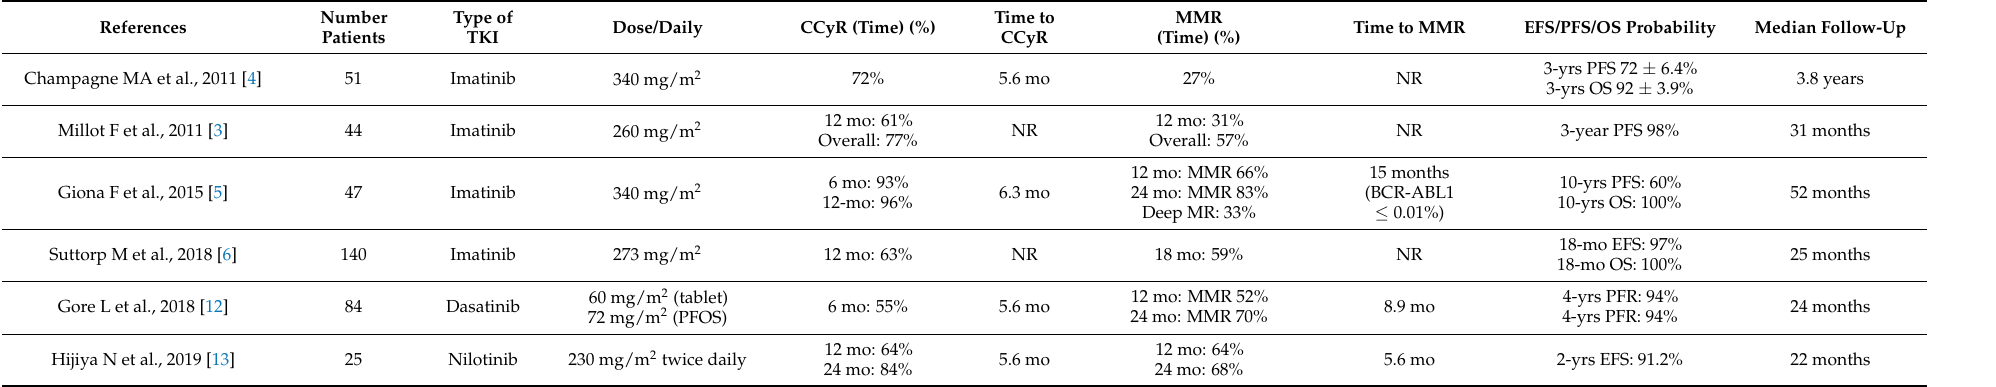
Table 1. Results of TKI treatment in larger studies of newly diagnosed CP-CML pediatric